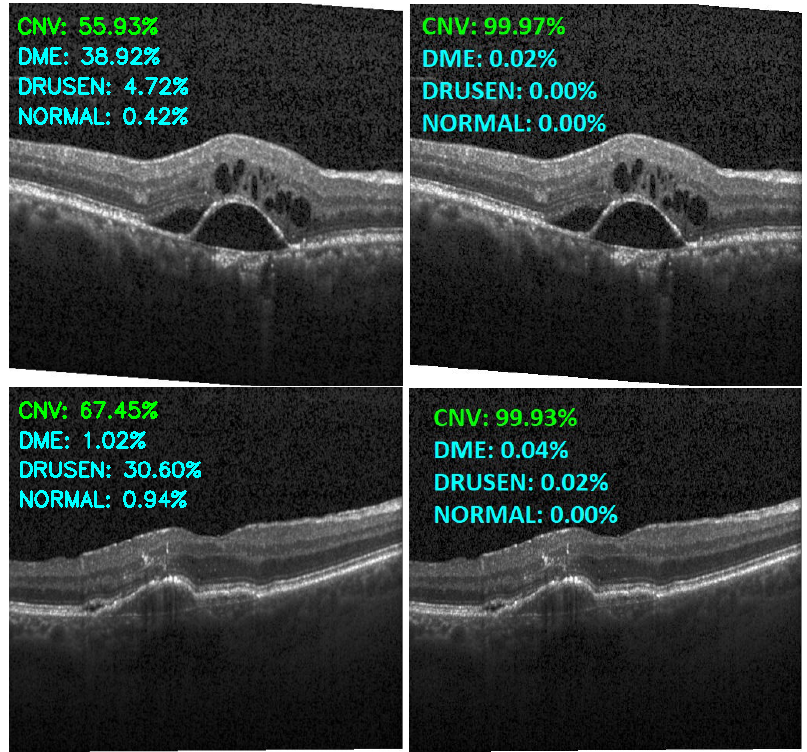
Figure 13. Exemplary result of proposed model trained without (left column) and with (right column) augmentation (correct label highlighted in